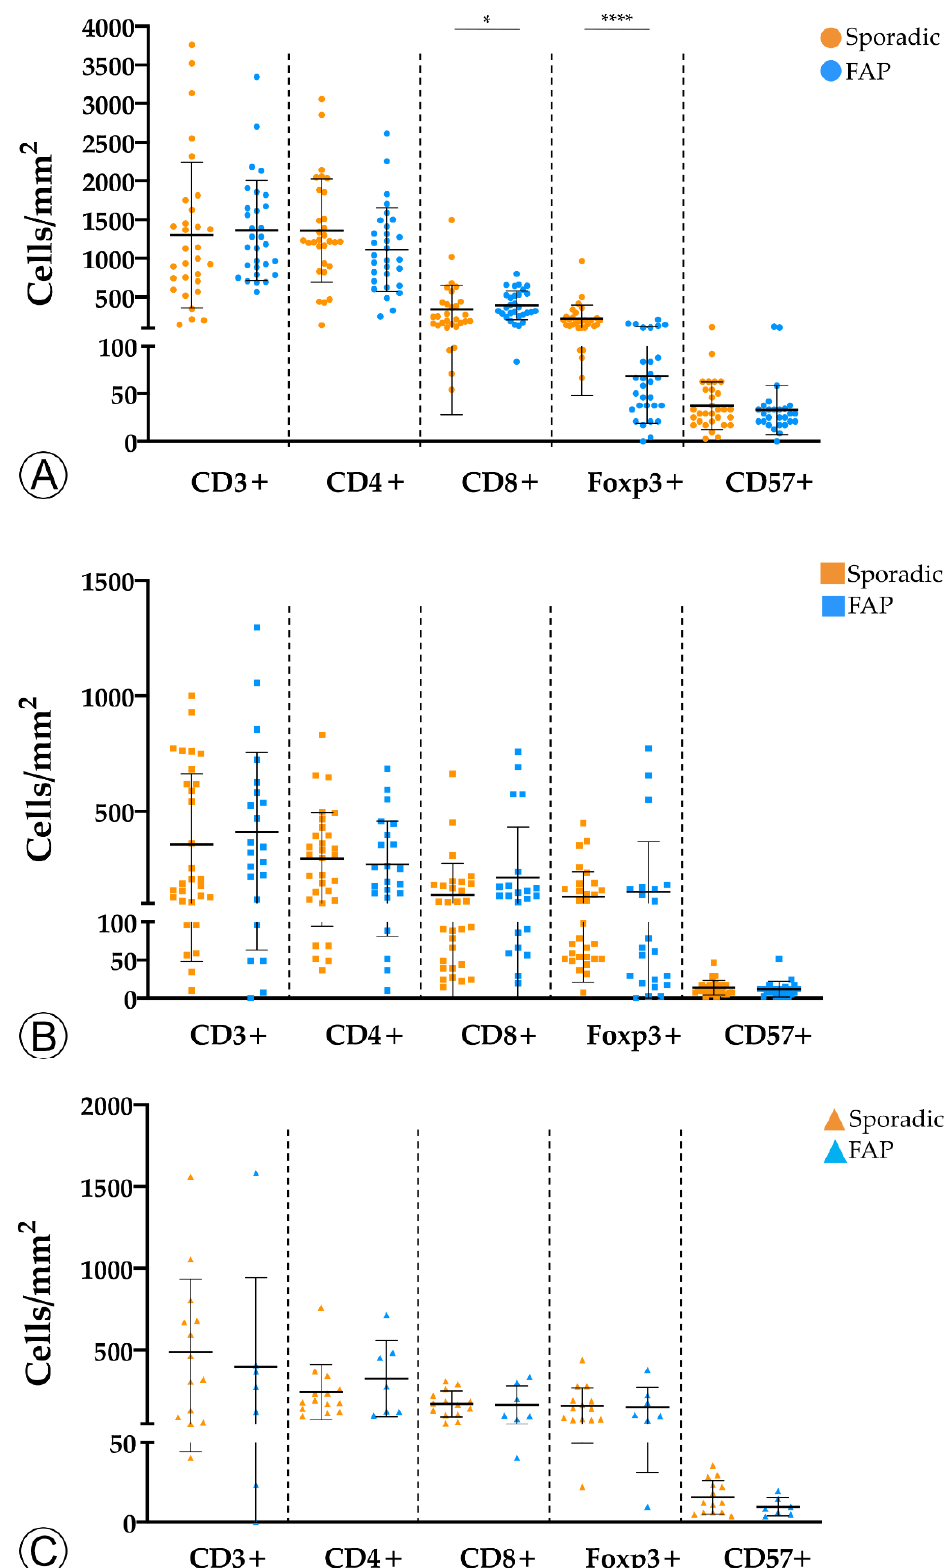
Figure 3. Comparison of immune cell counts between sporadic and hereditary Familial Adenomatous Polyposis (FAP)-related lesions in adenomatous lesions with low-grade dysplasia ( A ), adenomatous lesions with high-grade dysplasia ( B ), and invasive adenocarcinoma ( C ). * = p < 0.05; **** = p < 0.0001.